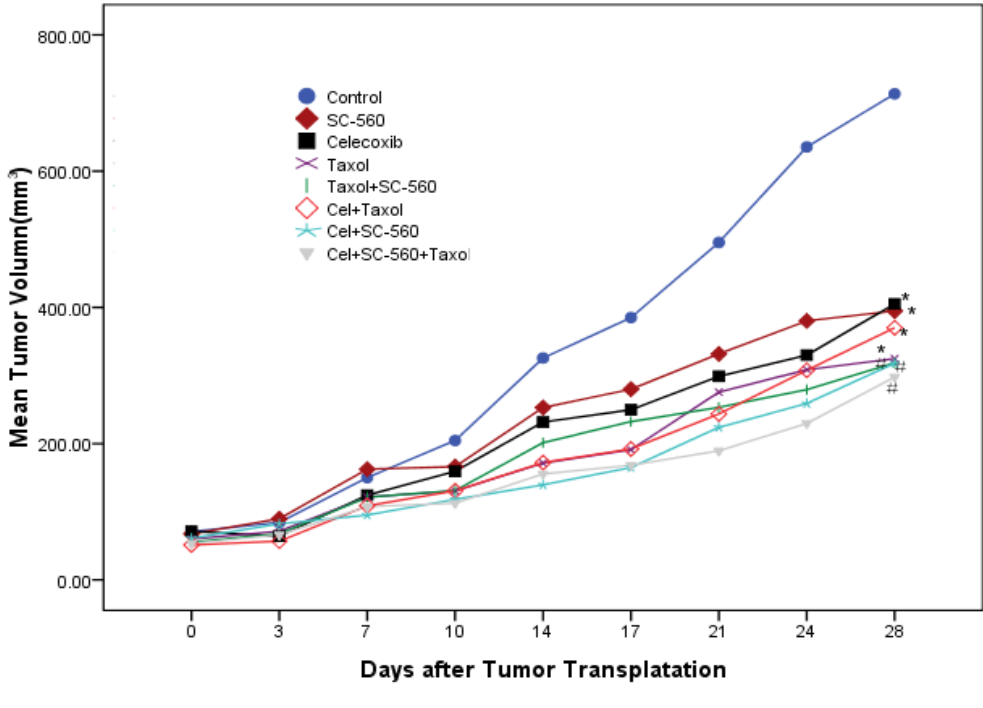
Figure 1. Effects of SC-560, celecoxib or/and taxol on tumor growth in vivo . The inhibitory of SC-560, celecoxib and taxol on tumor growth were determined in an ovarian cancer model using SKOV-3 cells. After 7 days to allow tumor establishment, mice were treated with SC-560, celecoxib and taxol. Treatment was continued for 21 days. The average tumor volume in all the drug-treated mice was significantly different from vehicle-treated mice at day 28. Statistical significance was determined using Least Significant Difference (LSD)- t test. * p < 0.05, # p <